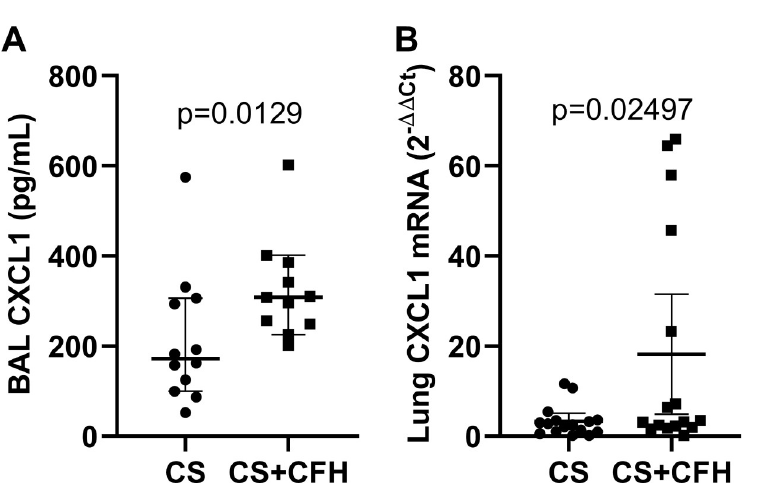
Fig 6. CFH increases lung inflammatory cytokine expression. (A) CXCL1 measured by ELISA increased in mouse BAL collected 24 hours after induction of sepsis in CS+CFH versus CS alone (n = 11–12, p = 0.0129). (B) Lung CXCL1 expression measured by PCR in whole lungs at 24 hours also increased in CS+CFH versus CS alone (n = 16, p = 0.02497).